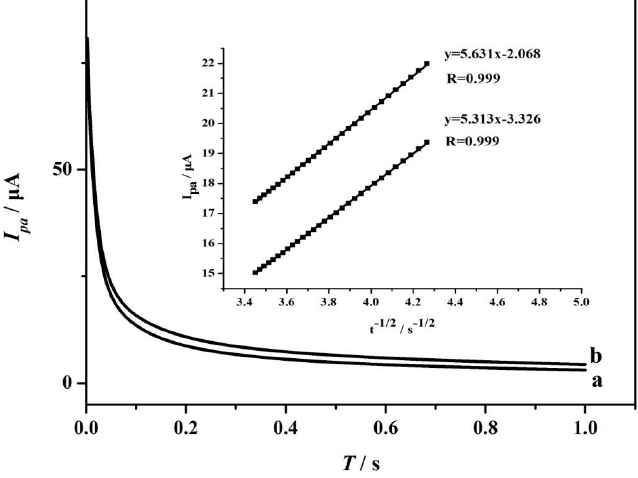
Figure 10. Chronoamperograms obtained at PME in the presence of 1.0 × 10 − 3 mol · L − 1 (curve a) and 1.0 × 10 − 2 mol · L − 1 (curve b) AA in the buffer solution (pH = 6). Inset: Cottrell’s plot for the data